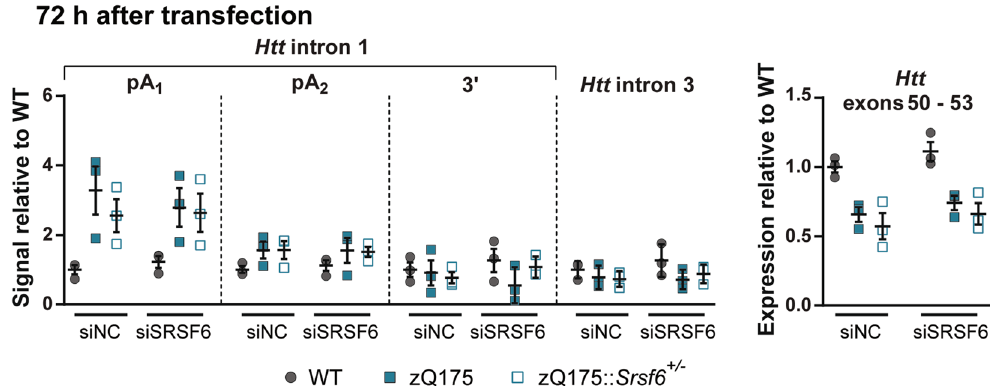
Figure 5. Measurement of Httexon1 and Htt transcripts in WT, zQ175 and zQ175:: Srsf6 +/ − MEFs after transfection with an siRNA targeting Srsf6 (siSRSF6). QuantiGene analysis was used to measure Httexon1 and Htt mRNA levels 72 h after siSRSF6 or siNC transfection. Neither Httexon1 nor full-length Htt